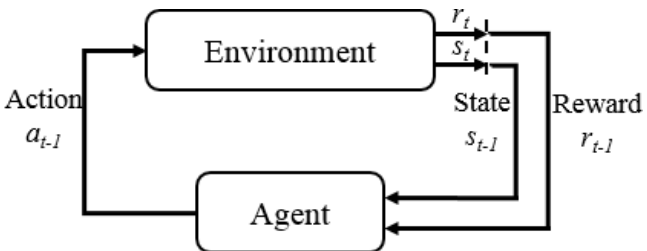
Figure 5. A figure showing the various components in a reinforcement learning problem setting. The dashed vertical line indicates a transition in discrete time/sequence. This diagram shows a full transition in states and reward from one time step to the